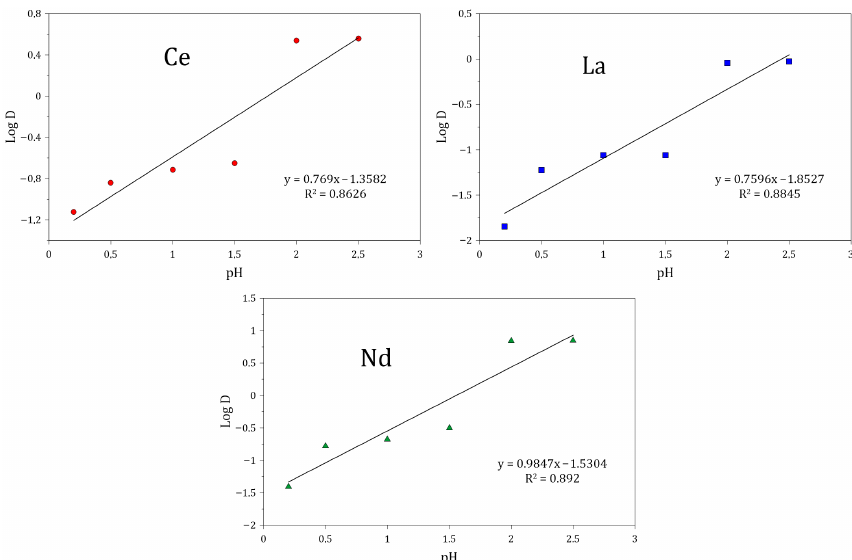
Figure 17. Log D vs. pH for the extraction of Ce , La , and Nd with Cyanex 572.